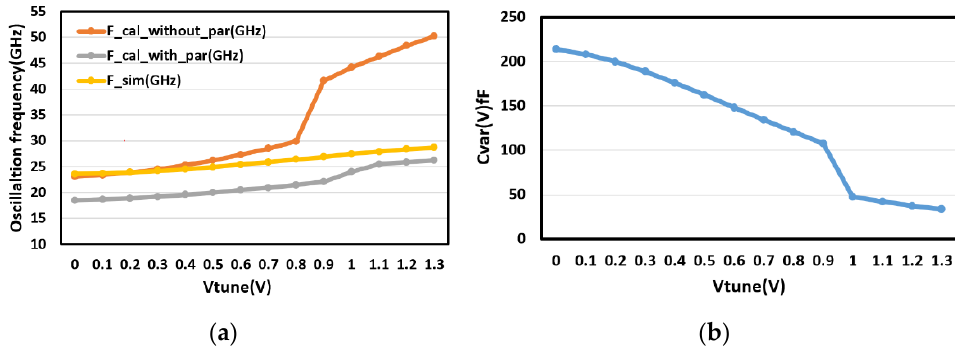
Figure 4. ( a ) Calculation and simulation results of oscillation frequency under different tuning voltage; ( b ) average capacitance under different tuning voltage.